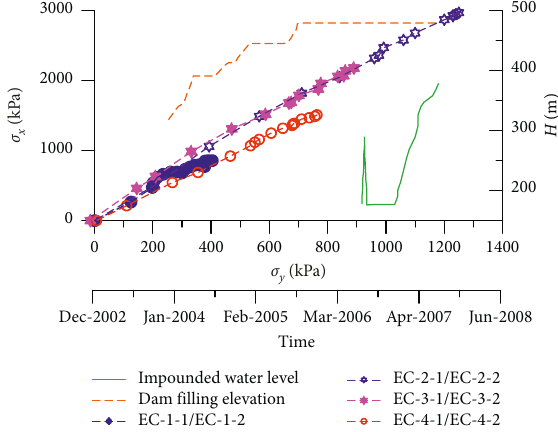
Figure 7: Stress gauge monitoring results of Sanbanxi Rockfill Dam (data from [21]). Table 2: Modified general plasticity model parameters.